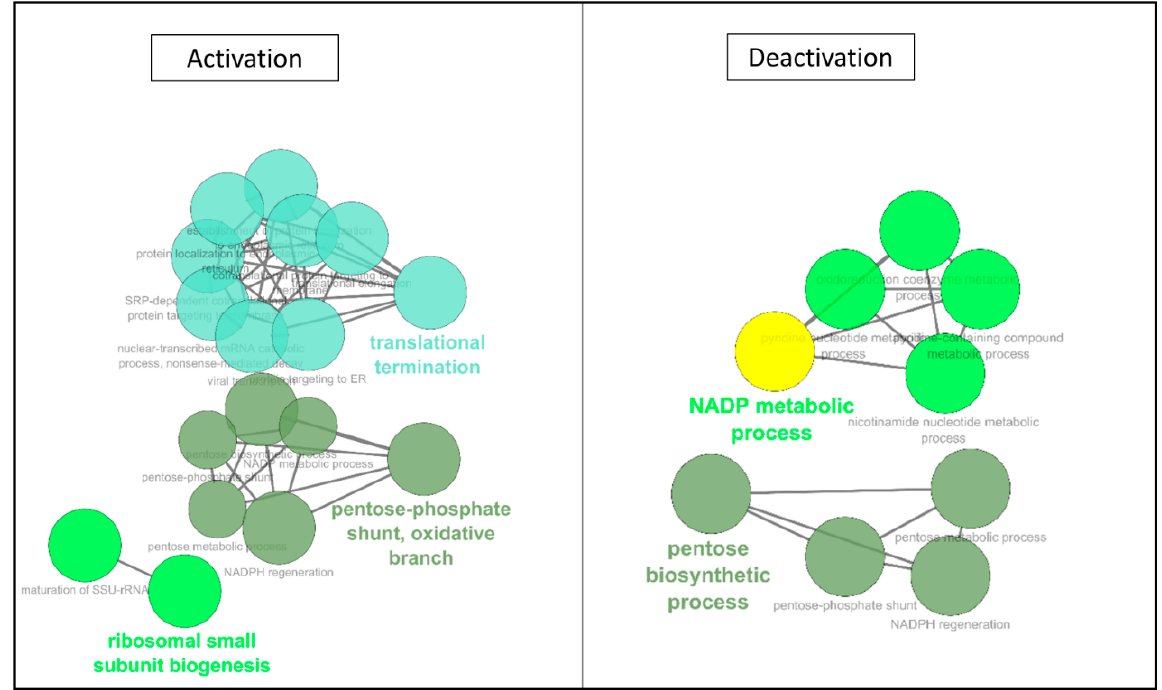
Figure 4. ClueGO Network Representation of Affected motifs between 0 and 3 h of hypothermic hypoxia. The list of protein motifs unaffected by the protocol were analyzed in Cytoscape’s ClueGO to identify their ontology and network associations. Results are illustrated as a functionally grouped network of terms/pathways. The most significant term of a group is considered to be the leading terms and is highlighted (bolded name). Disc size represents the number of motifs identified in the specified ontology (small: 3–6; medium: 7–9; large: 10 and more).